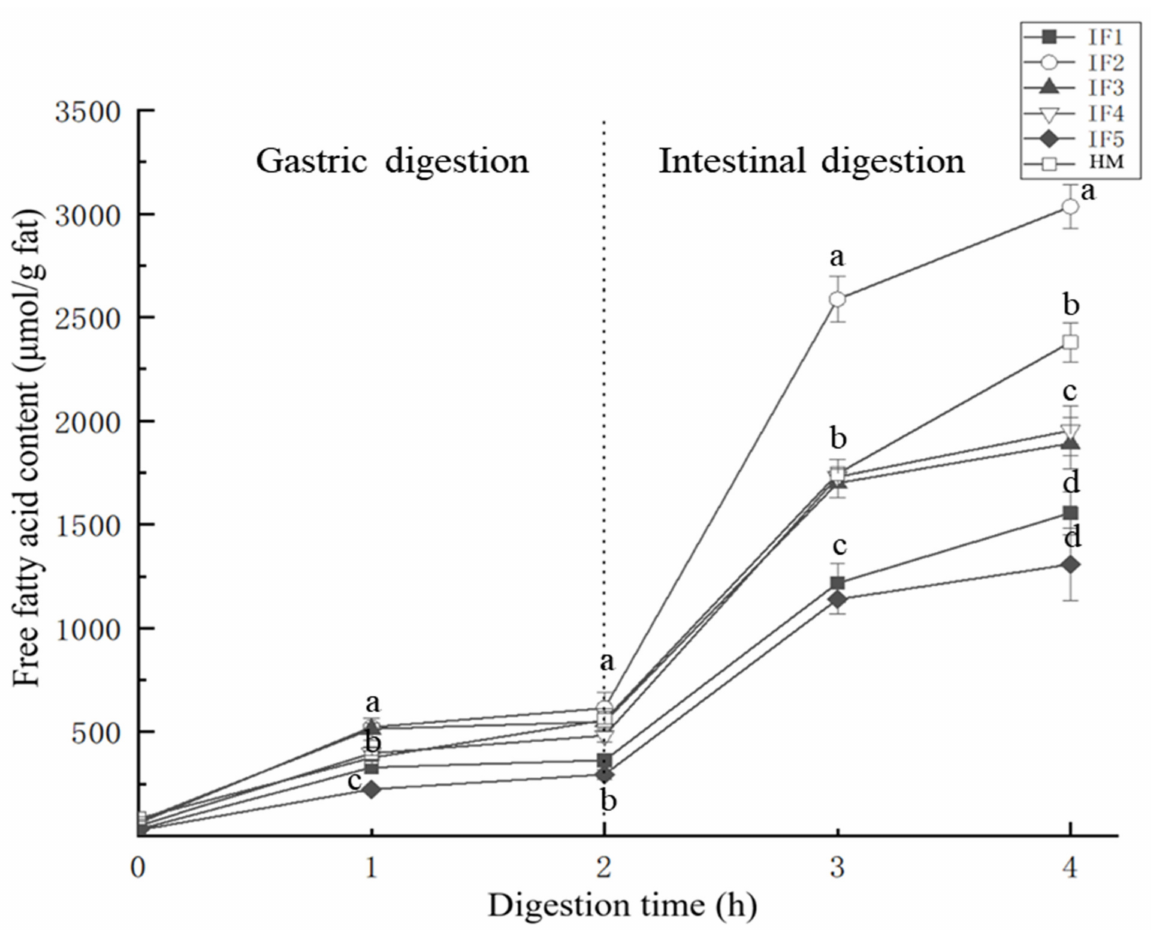
Figure 2. Free fatty acids released from infant formulas and human milk during digestion. IF1: veg- etable oil-based formula; IF2: vegetable oil-based formula with MFGM; IF3: bovine milk/vegetable oil-based formula with cream; IF4 bovine milk/vegetable oil-based formula with cream and soybean phospholipid; IF5: whole fat milk power/vegetable oil-based formula. a–d Values with different superscripts differ significantly with respect to different